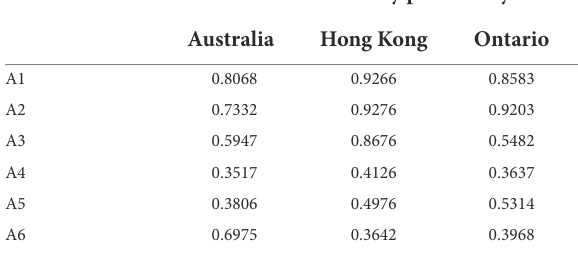
Table 2 Attribute mastery probabilities across three